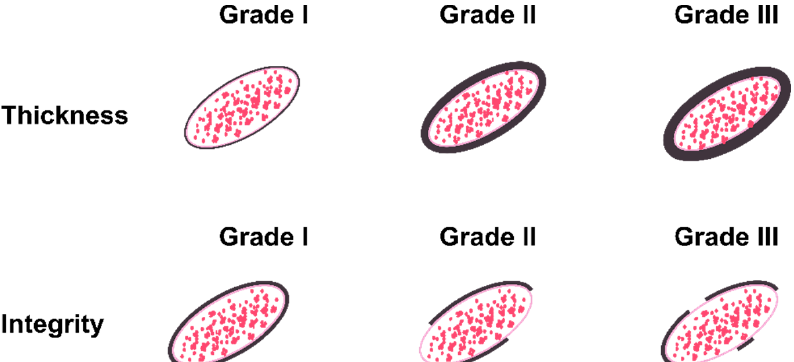
Figure 1. Semi-quantitative grading scale used for analysis of the thickness and integrity of the vascular BM. Red dots symbolize erythrocytes. Each vessel was analyzed for both these parameters individually in five random visual fields per region, per sample for both gray and white matter. Grade I represents normal vessels. Grade II represents moderately damaged vessels. Grade III represents severely damaged vessels.